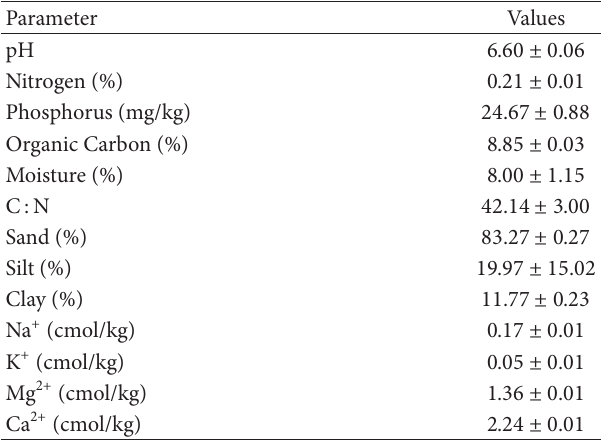
Table 1: Physicochemical properties of soil used for phytoremedia- tion